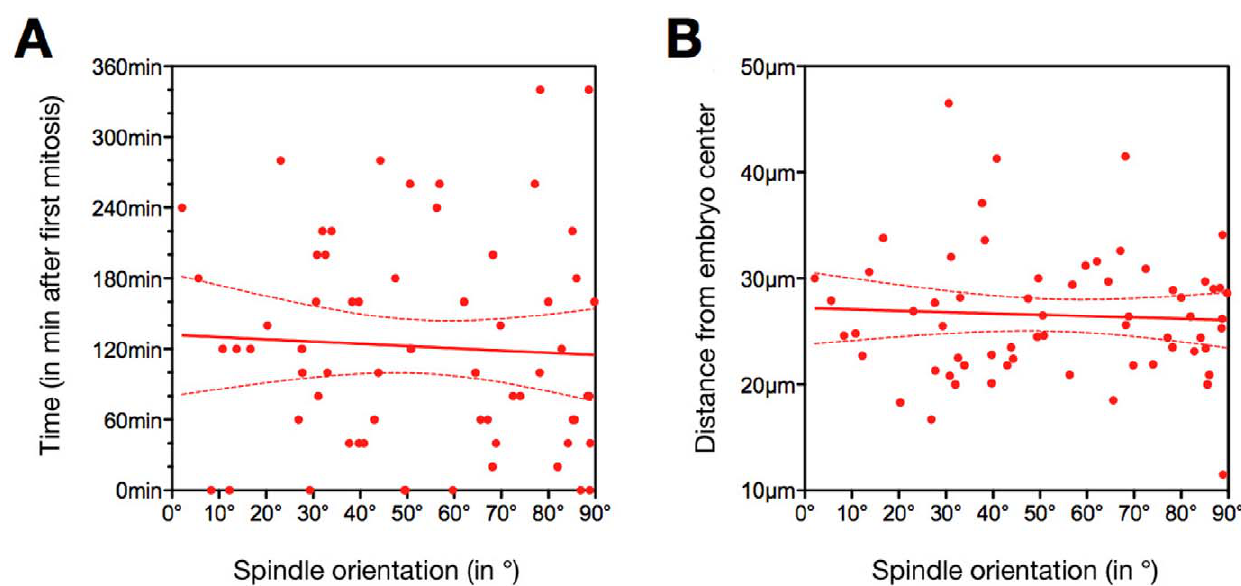
Figure 7. Spindle orientation is not modulated by the timing of division nor the position of blastomeres. Correlation between spindle orientation (X axis) and the timing of division (A; Y axis) or the distance from the embryo centre (B; Y axis).